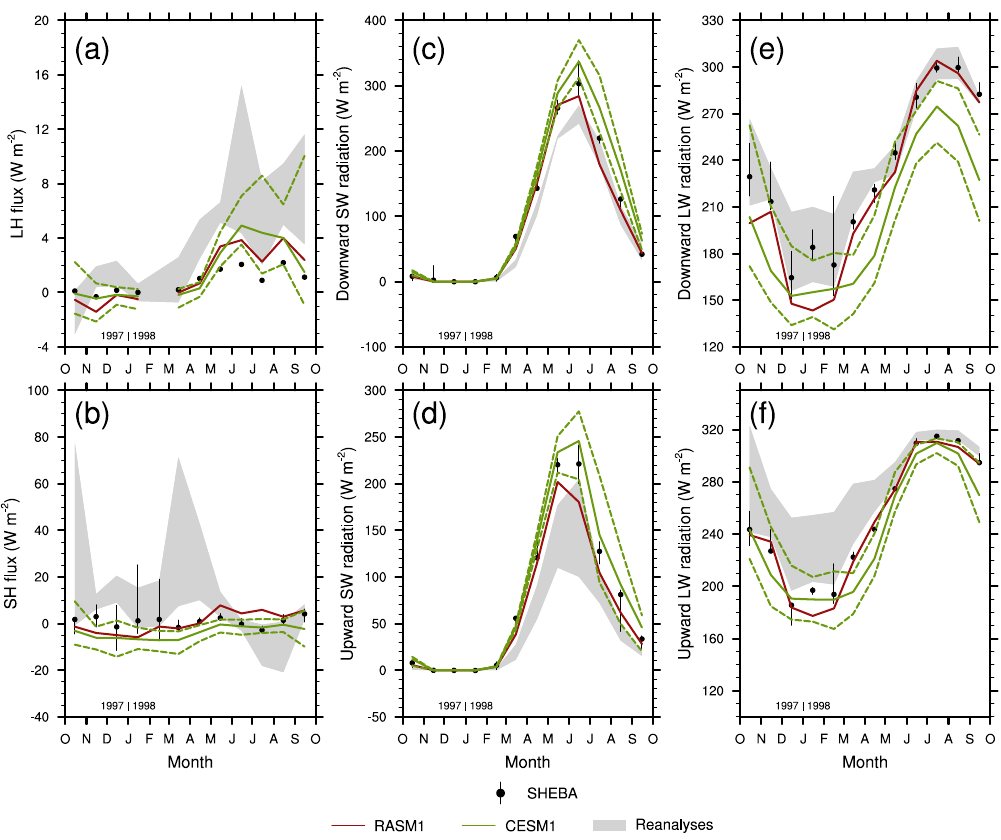
Figure 13. Comparison of monthly mean (a) latent heat (LH) flux, (b) sensible heat (SH) flux, (c) downward incident shortwave (SW) radiation, (d) upward reflected SW radiation, (e) downward incident longwave (LW) radiation, and (f) upward emitted LW radiation from SHEBA observations (black) with RASM1 (red), CESM1 (green), and reanalyses (gray shading). Positive LH and SH fluxes indicate upward fluxes. Observational spread is indicated by the vertical black lines extending from the circles, and the spread in reanalyses is shown by the gray shading. The green dashed lines surrounding CESM1 indicate the ensemble range (minimum to maximum). No LH flux measurements are available in February